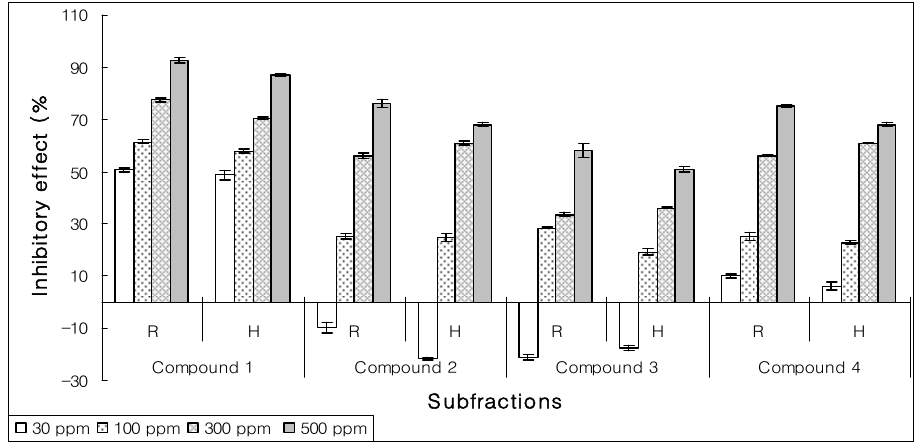
Figure 6. Effect on the growth of lettuce seeds of four purified compounds from 50% methanol: chloroform subfraction using RP-HPLC.